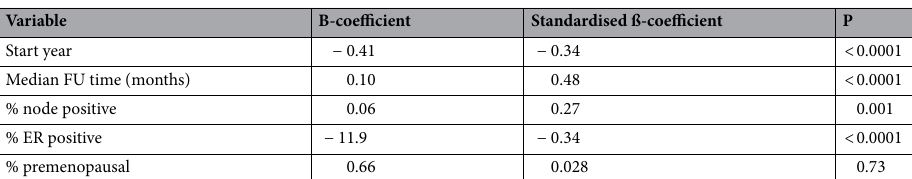
Table 2. Multivariate linear regression for distant DFS events as a percentage of total participants randomized, weighted by sample size (n = 68). R 2 0.68. FU follow-up, ER estrogen receptor.